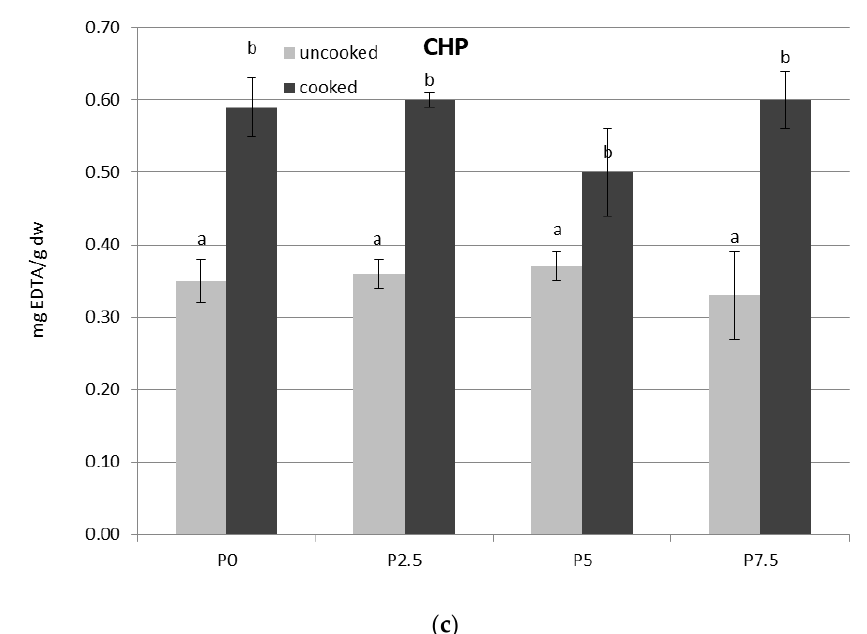
Figure 2. Antioxidant activity of extracts from uncooked and cooked pastas fortified with onion skin powder. P0—control pasta; P2.5–7.5 pastas fortified with 2.5–7.5% (m/m) of onion skin powder; ( a ) ABTS + —radical-scavenging ability against ABTS + · ; ( b ) RP—reducing power; ( c ) CHP—chelating power. Different letters indicate significant difference ( p < 0.05).